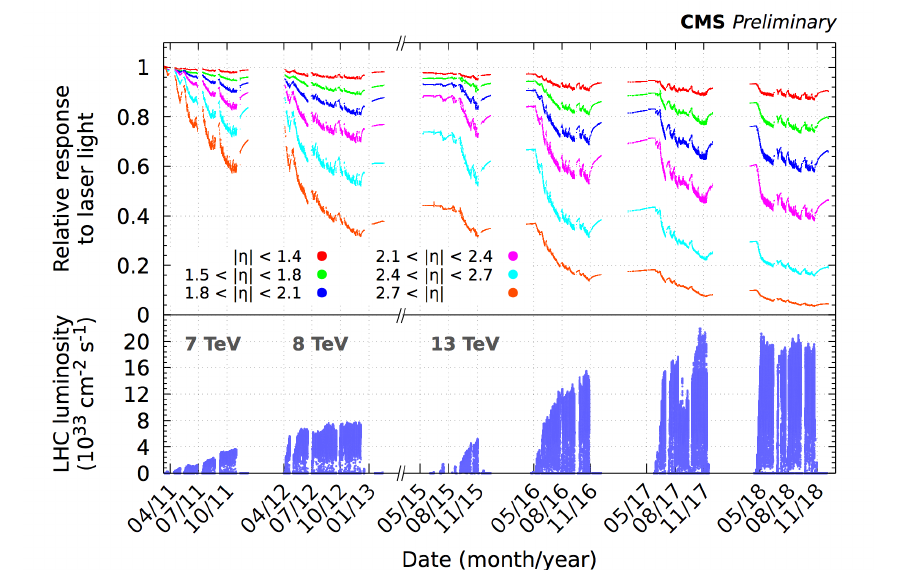
Figure 1. Evolution of the ECAL channel response to laser light versus time since 2011. The channels are subdivided in ranges of η . The bottom panel shows the instantaneous luminosity delivered by the LHC in the same time